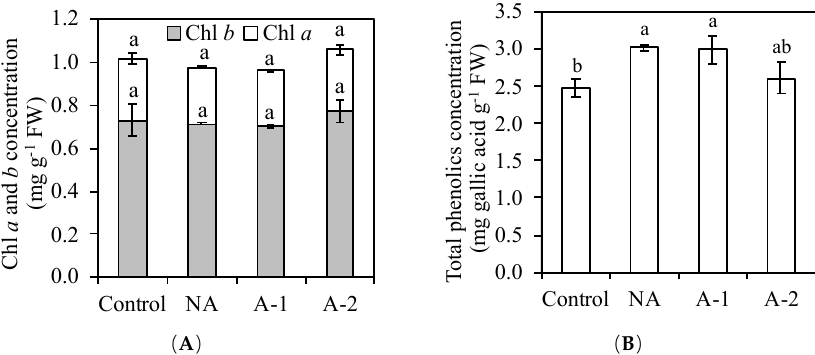
Figure 2. Effects of 10-days sodic-alkalinity with 100 mM NaHCO3 on chlorophyll (Chl) a and b contents ( A ) and total phenolics content ( B ) in the leaf tissues of pre-acclimated rye. Rye plants were pre-acclimated by 0 mM NaHCO 3 (NA) and 1 and 2 mM NaHCO 3 (A-1, A-2) for 10 days. Control plants were consistently irrigated by nutrient solution. Significance testing was performed using ANOVA analysis followed by Duncan’s multiple range test at p ≤ 0.05. The values are means ( ± SE) of five replicates. Means followed by the same letter are not significantly di ff